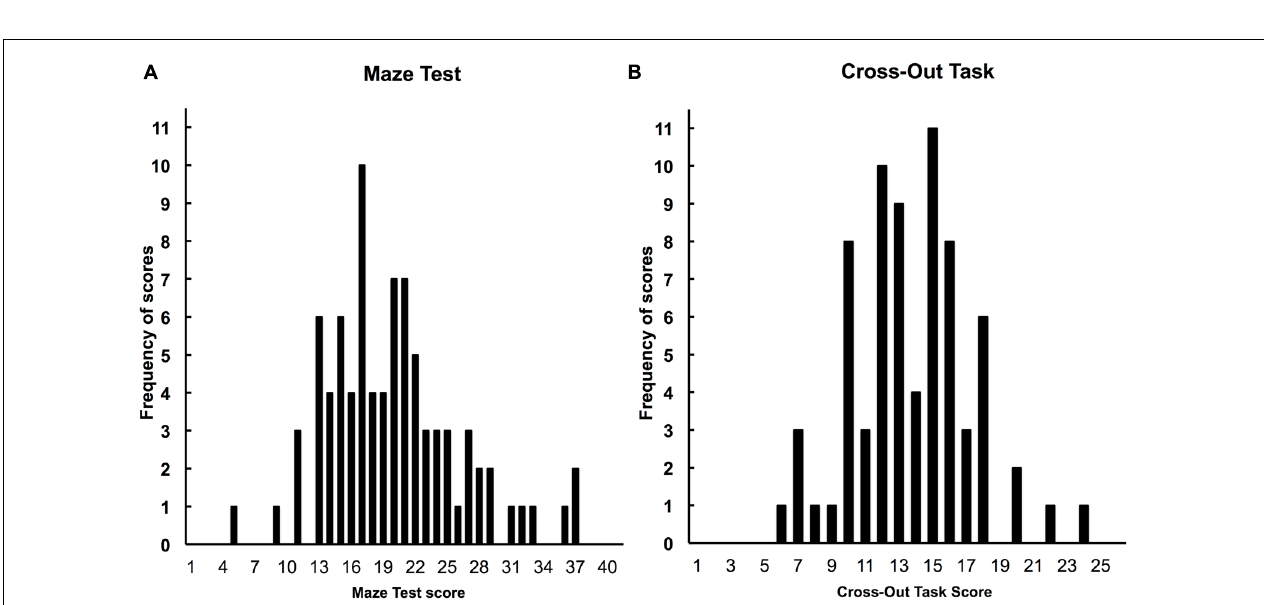
FIGURE 3 | Overall frequency distribution of Maze reading comprehension scores (A; skewness = 0.42; kurtosis = 0.93) and Cross-Out processing speed scores (B; skewness = 0.22, kurtosis = 0.32) combined for children from all experiments.